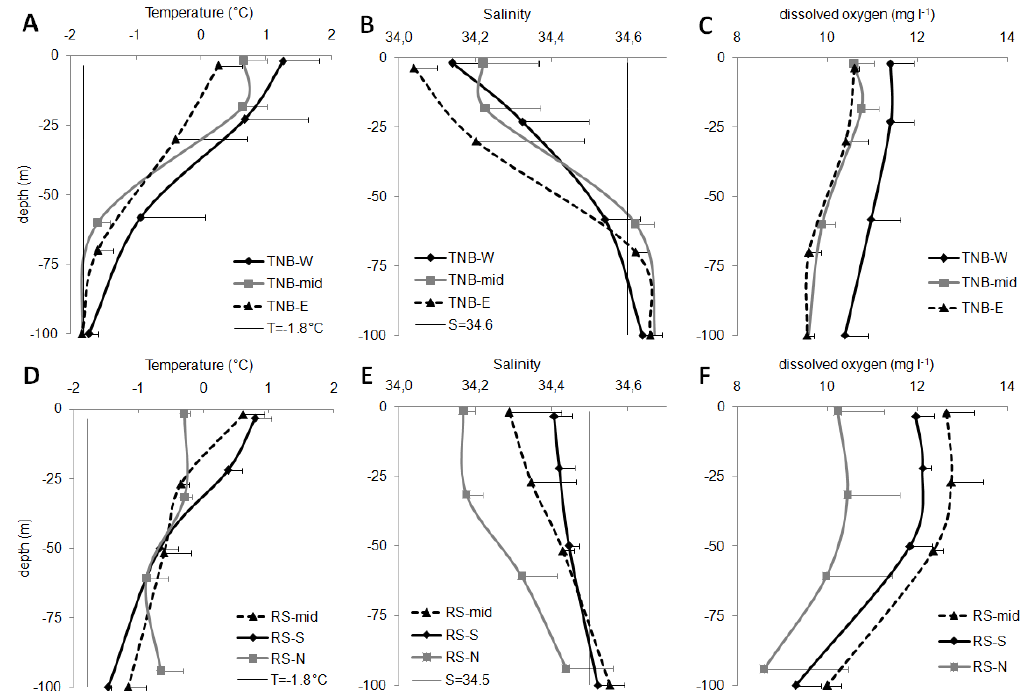
Figure 2. Physical and chemical variables of the epipelagic layer. Average values (+sd) for the two macro-areas (coastal TNB, upper panels, and offshore RS, lower panels), see text for details related to the sub-areas. ( A , D) : temperature (°C), the thin vertical line denotes the T value (−1.8 °C) indicated as the lower limit for Antarctic surface waters (AASW) [36]; ( B , E ): salinity, the thin vertical line denotes the S value indicated as the higher limit for surface waters in TNB (34.60) [5] and in RS (34.50) [36]; ( C , F ): dissolved oxygen concentration (mg L − 1 ). Many depths were measured for physical-chemical parameters, we only reported four points for similarity with other figures.